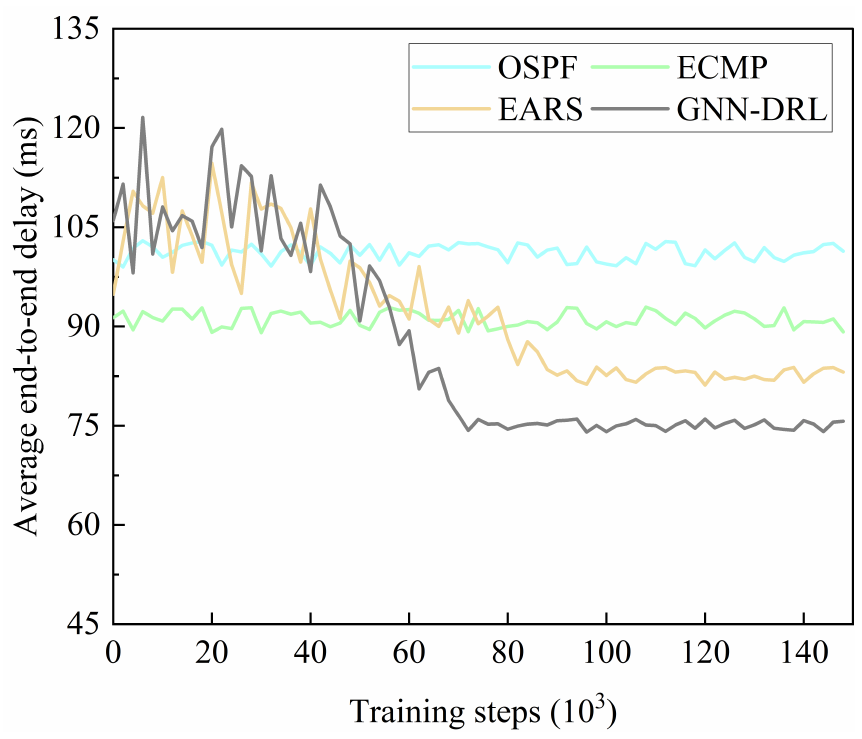
Figure 10. Optimization effect of average end-to-end delay under 120 Mbps traffic